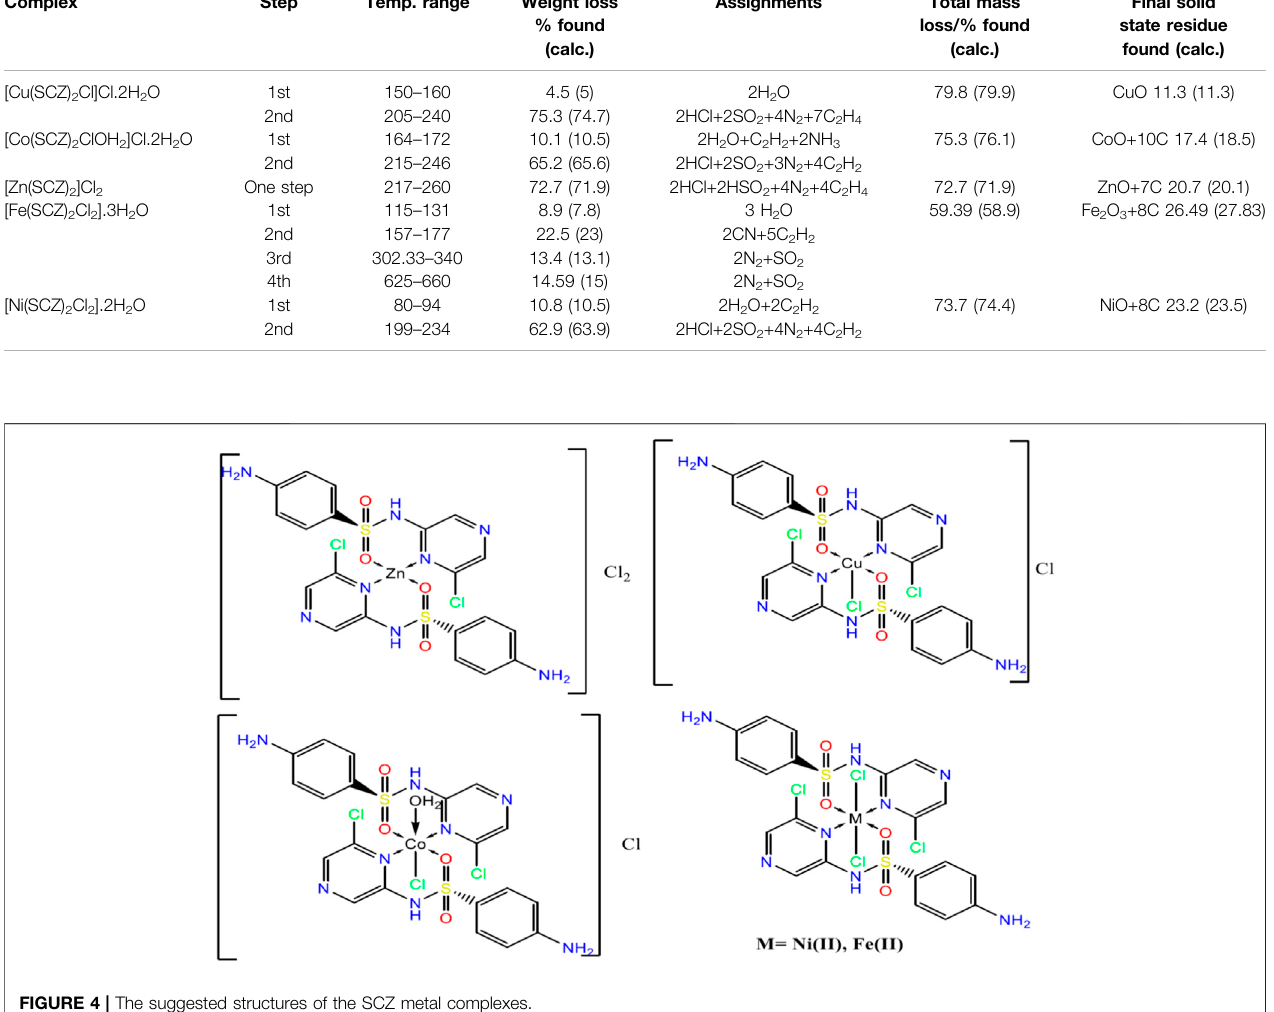
Final solid loss/% found state residue (calc.) found (calc.)